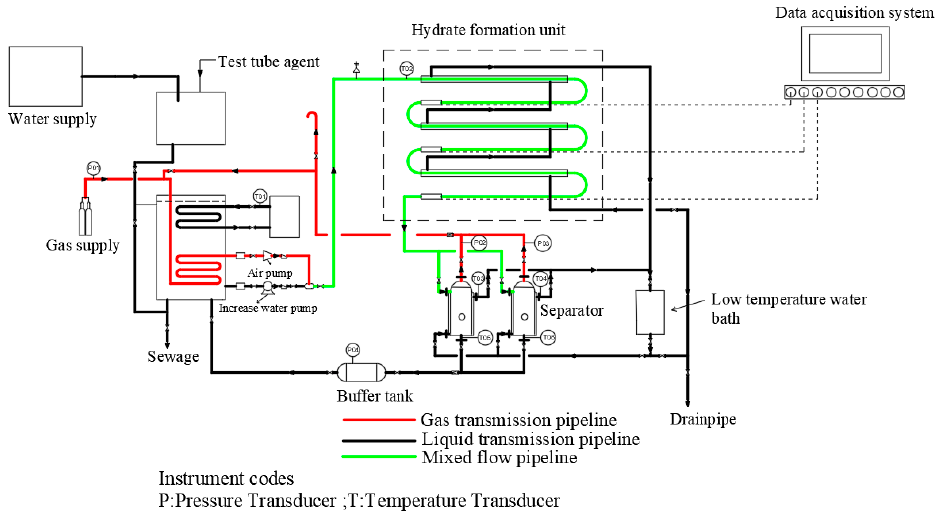
Figure 4. Schematic diagram of the hydrate spiral flow loop.